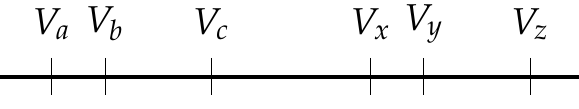
Figure 1. Geometric representation of